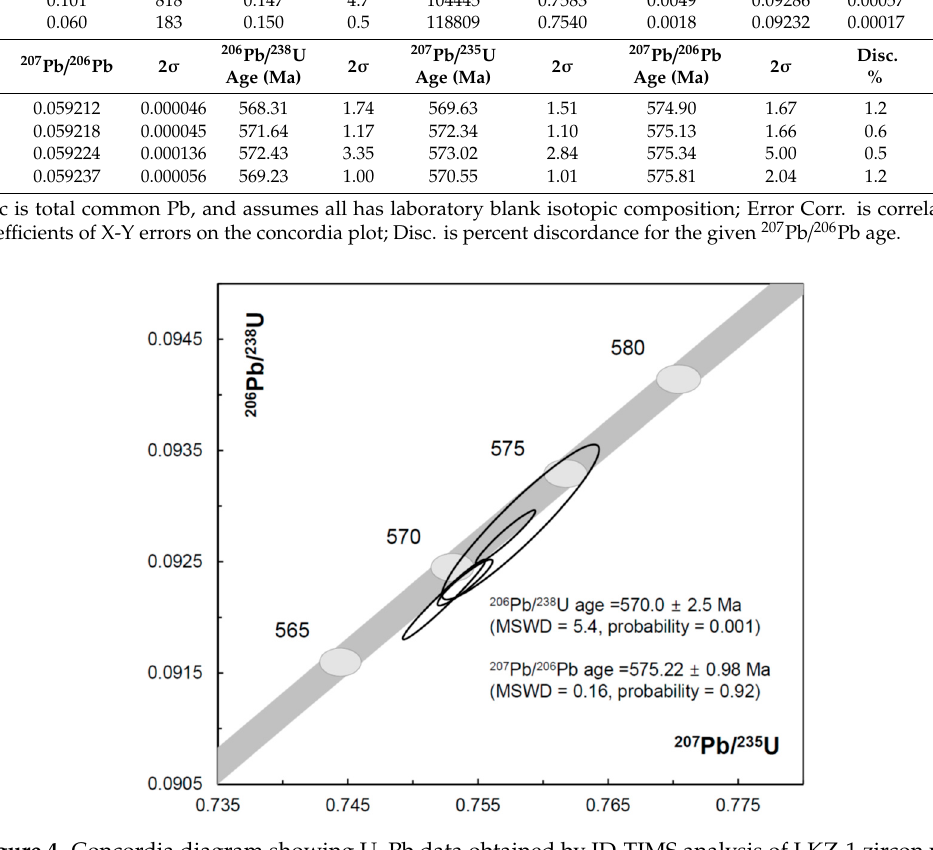
Figure 4. Concordia diagram showing U–Pb data obtained by ID-TIMS analysis of LKZ-1 zircon with ± 2 σ error ellipses. The concordia curve is depicted as a band, which incorporates the uncertainty of the U decay constants.